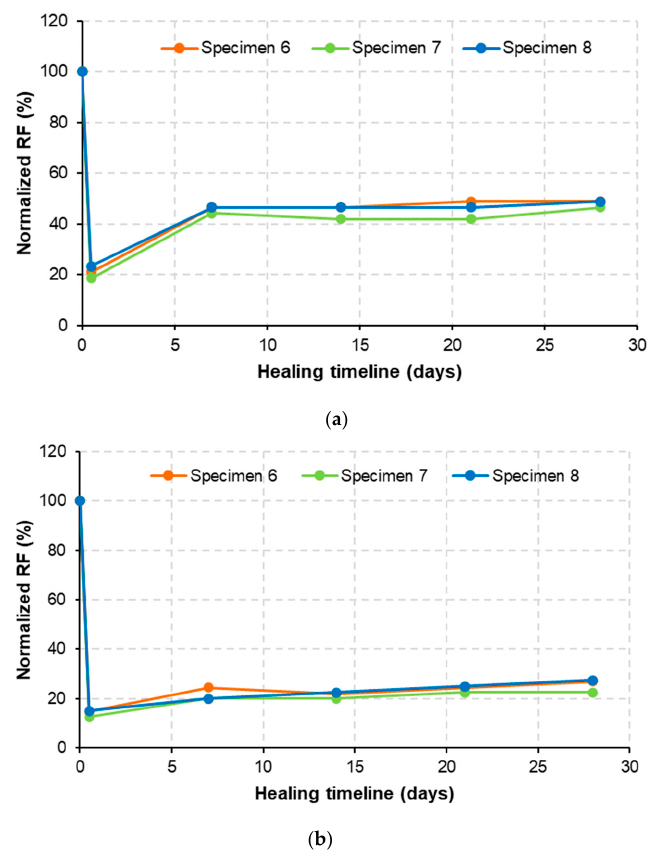
Figure 9. Normalized RF of: ( a ) M-W and ( b ) M-O mixtures. After pre-cracking, the normalized RF values of the M-W and M-O mixtures were reduced by about one-fifth compared to the original values. This was because pre-cracks broke down the structural integrity of the specimens, significantly lessening wave trans- mission caused by impact load. Later, normalized RF values of the two mixtures increased gradually over the healing timeline, implying that healing materials were created inside the pre-cracks, partially sealing cracking gaps and improving the stiffness property of composite structures. At 28 healing days, the normalized RF values of the M-W and M-O mixtures were higher than the initial normalized RF values by 27%p and 12%p, respec- tively. This indicates that both mixtures had crack-healing potential upon stiffness recov- ery; however, the M-W mixture acquired much better healing properties than the M-O mixture. It is necessary to mention that the M-O mixture showed a relative stiffness re- covery but low crack sealing capacity (Section 3.2). It is likely that the healing materials formed on the cracking surfaces of the M-O mixture were washed out by the rainfall. 3.4. Tensile Properties at Post-Healing Figure 10 shows tensile stress–strain curves describing pre-loading and re-loading phases of the M-W and M-O mixtures. The reloading curves were drawn according to the cyclic loading condition to eliminate residual tensile strain of pre-cracks when they re- opened. The specimens of the two mixtures showed strain-hardening behavior; however, their tensile ductility decreased compared to those of specimens tested at 28 days of age. Table 7 lists the tensile strength ( 𝑓 (cid:3047)(cid:3046)(cid:2879)(cid:3035) ) and tensile strain capacity ( 𝜀 (cid:3030)(cid:2879)(cid:3035) ) values at post- healing of the M-W and M-O mixtures, determined from the re-loading curves. Figure 11 shows normalized tensile performance at post-healing compared to that at 28 days of age (Table 5). Although the two mixtures showed quite different levels of crack-healing per- formance, they showed similar normalized tensile performance at re-loading after 28 heal- ing days. For two mixtures, their 𝑓 (cid:3047)(cid:3046)(cid:2879)(cid:3035) was almost unchanged compared to that of 𝑓 (cid:3047)(cid:3046) while their 𝜀 (cid:3030)(cid:2879)(cid:3035) was reduced a quarter compared to that of 𝜀 (cid:3030) . It is likely that the healing materials attached along the fibers bridging existing cracks might induce an increase in the interfacial bonding strength, which resulted in decreased crack width. Increased cracking strength might also decrease the number of cracks.